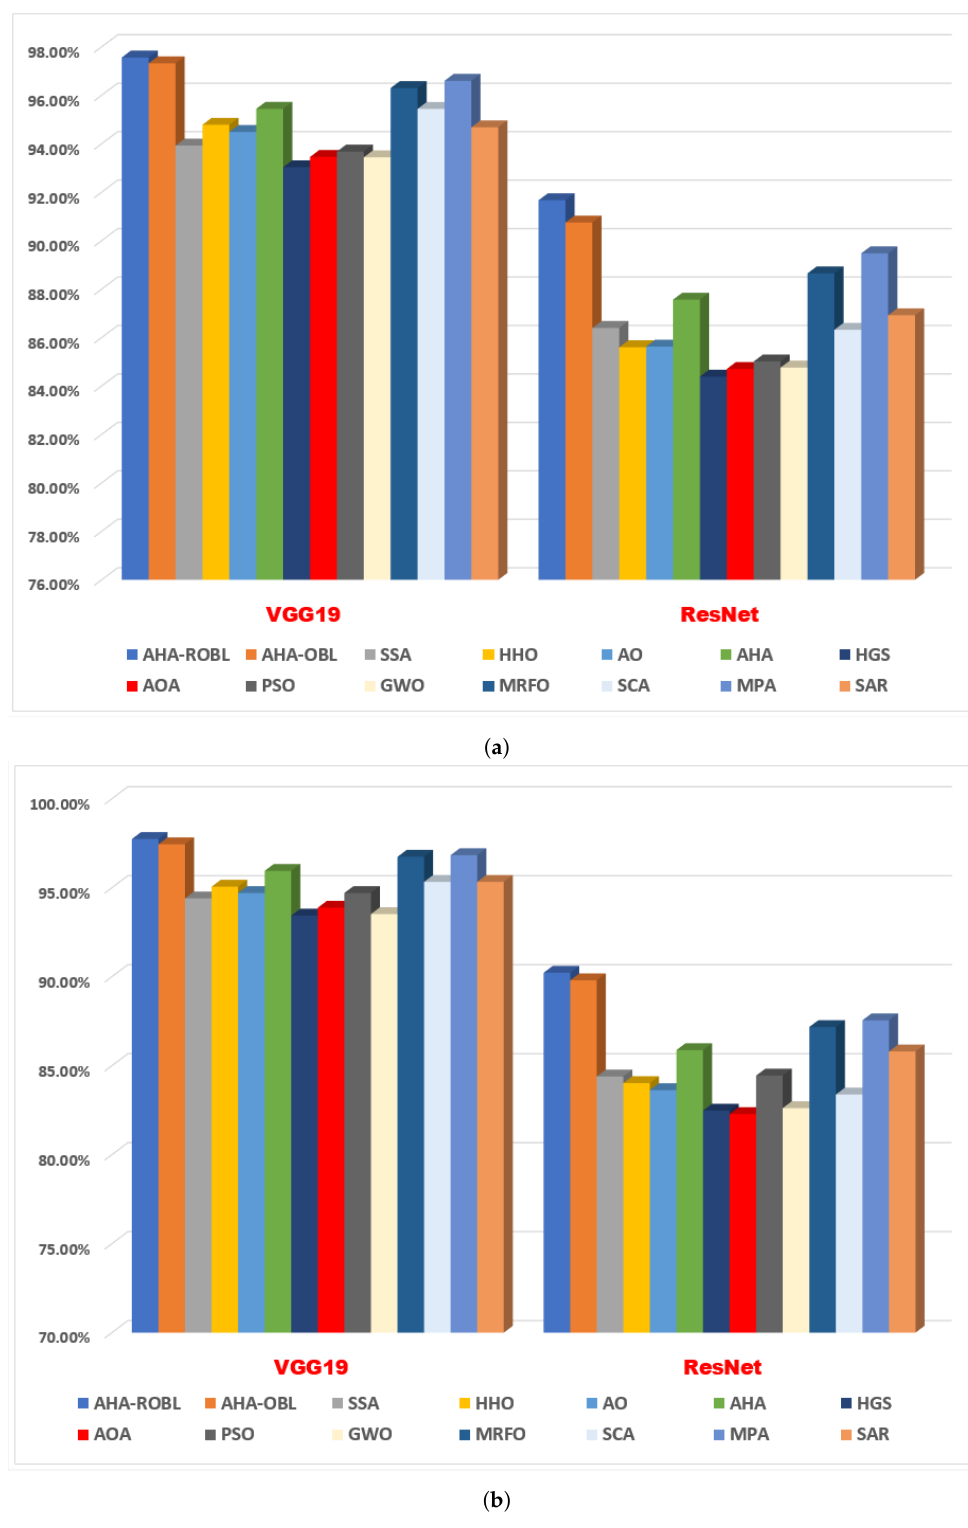
Figure 9. ( a ) Avg. precision of the proposed approaches versus other algorithms using VGG19 and ResNet20 and ( b ) avg. recall of the proposed approaches versus other algorithms using VGG19 and